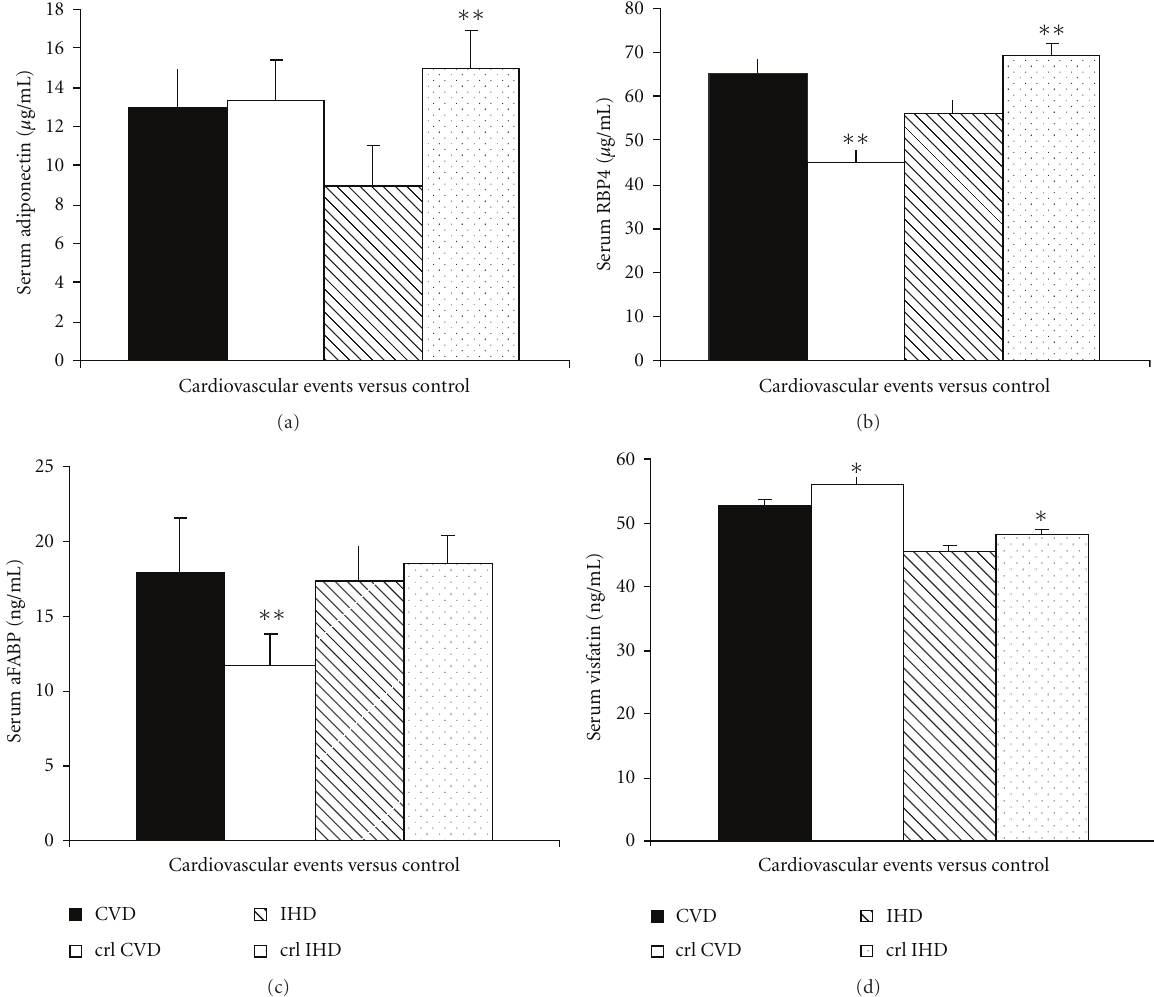
Figure 1: Comparison of mean adipocytokines levels between cases (black bars) of IHD and CVD and their controls (white bars). ∗ P < 0.05, ∗∗ P < 0.01. (a) Adiponectin is significantly reduced only in IHD with respect to controls. (b) RBP4 is reduced in a significant manner in IHD and increased significantly in CVD with respect to controls. (c) aFABP is significantly increased only in CVD with respect to controls. (d) Visfatin is significantly reduced both in IHD and CVD with respect to